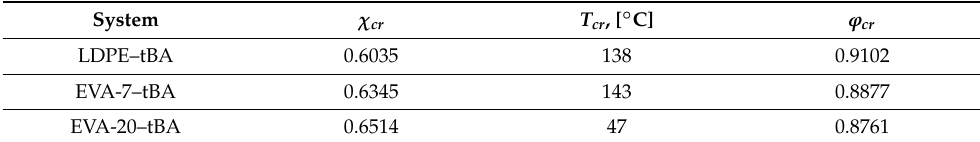
Table 2. The critical values for LDPE–tBA, EVA-7–tBA, and EVA-20–tBA systems according to the Flory–Huggins theory.